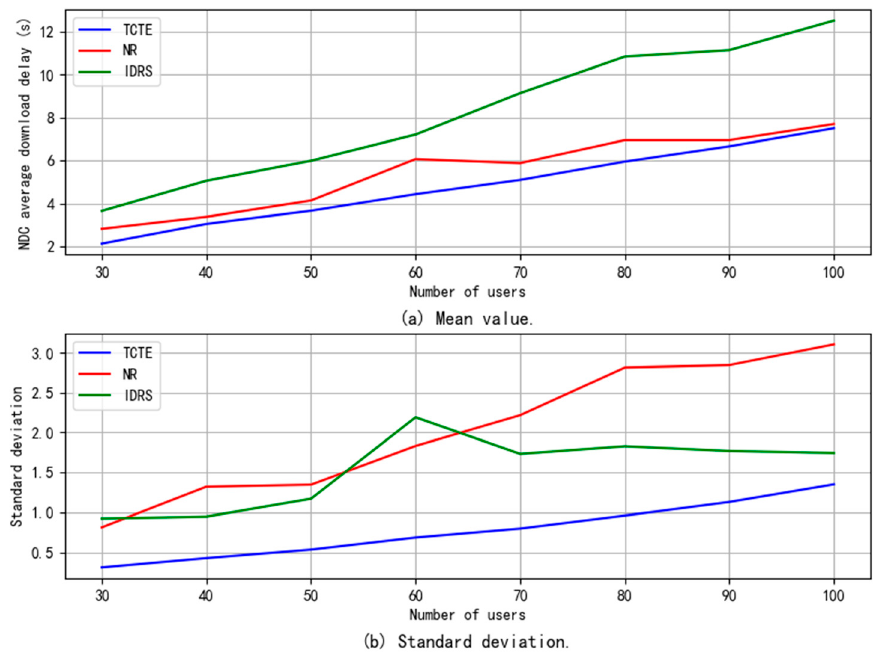
Figure 13. Mean and standard deviation of the NDC average download delay in Experimental Scenario 2.